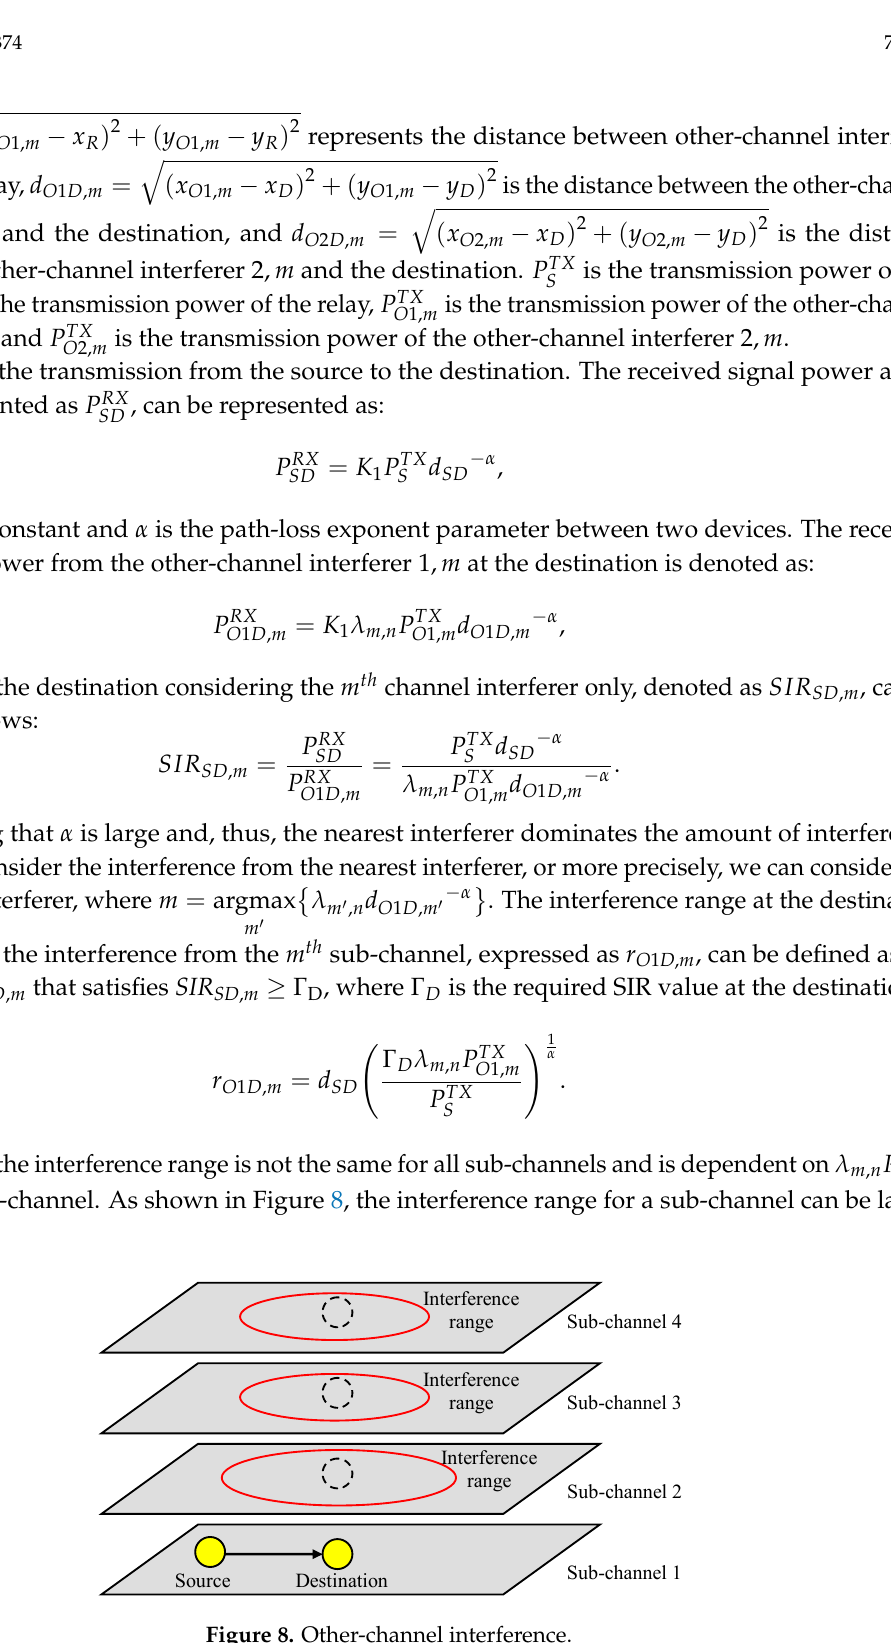
Figure 8. Other-channel interference.